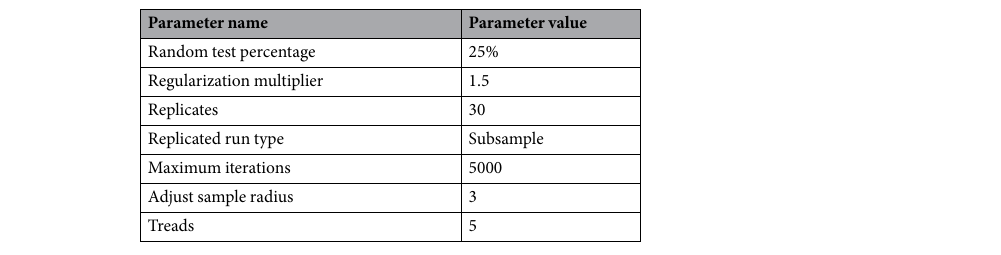
Table 2. Settings of partial parameters of Maxent model